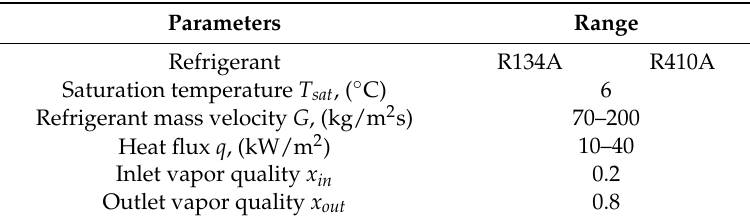
Table 4. Experimental